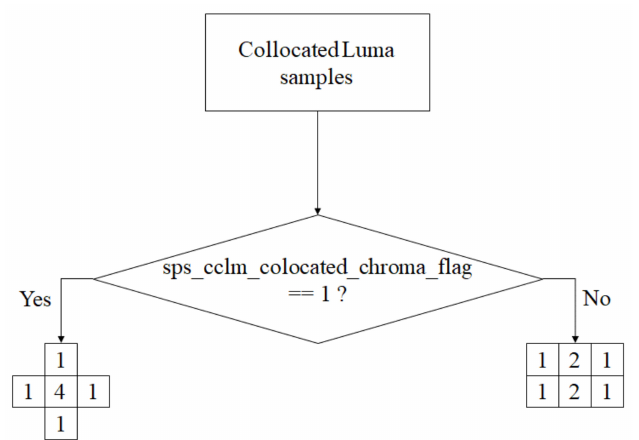
Figure 10. Flow chart of downsampling filter shape selection for collocated luma samples in the proposed CCLM.